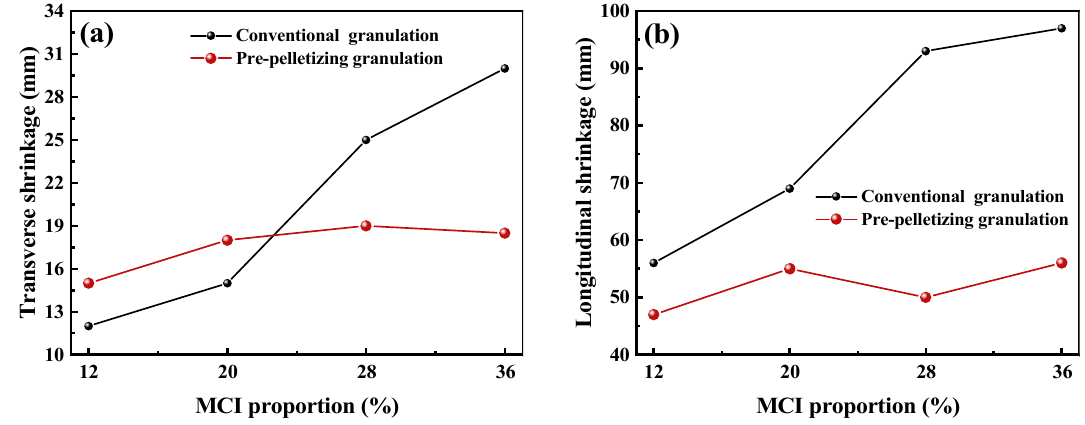
Figure 7. Transverse ( a ) and longitudinal ( b ) shrinkage of sinter.